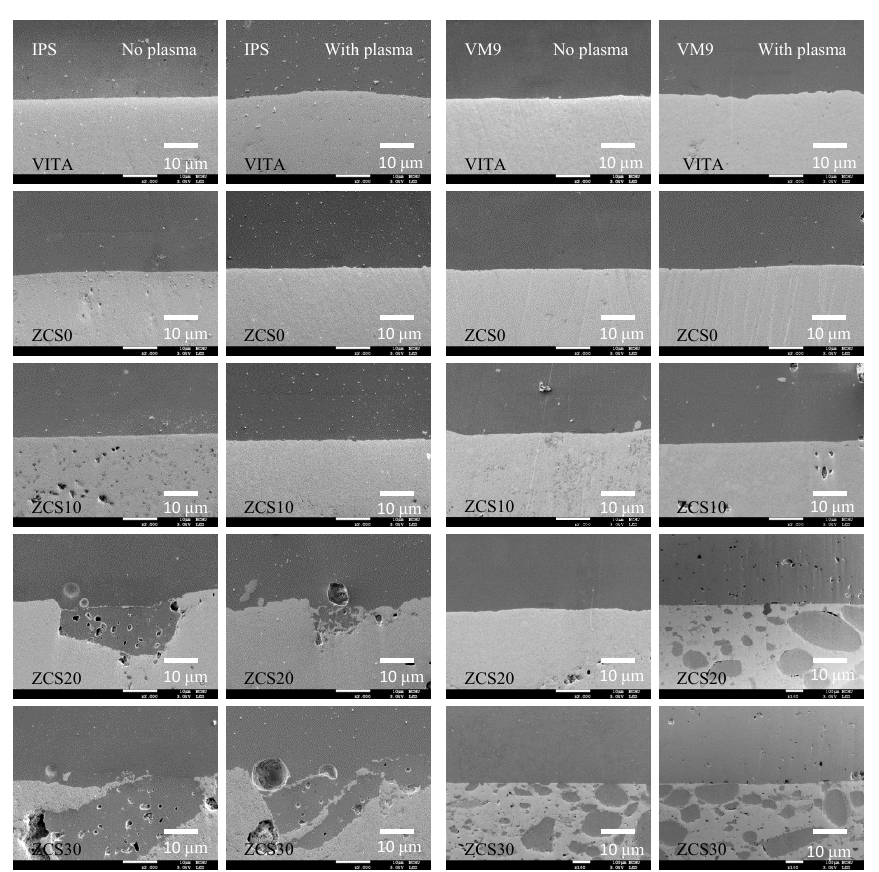
Figure 5. Cross-sectional SEM images of various core substructures bonded to VM9 or IPS e.max Ceram veneer ceramics before and after plasma treatment.